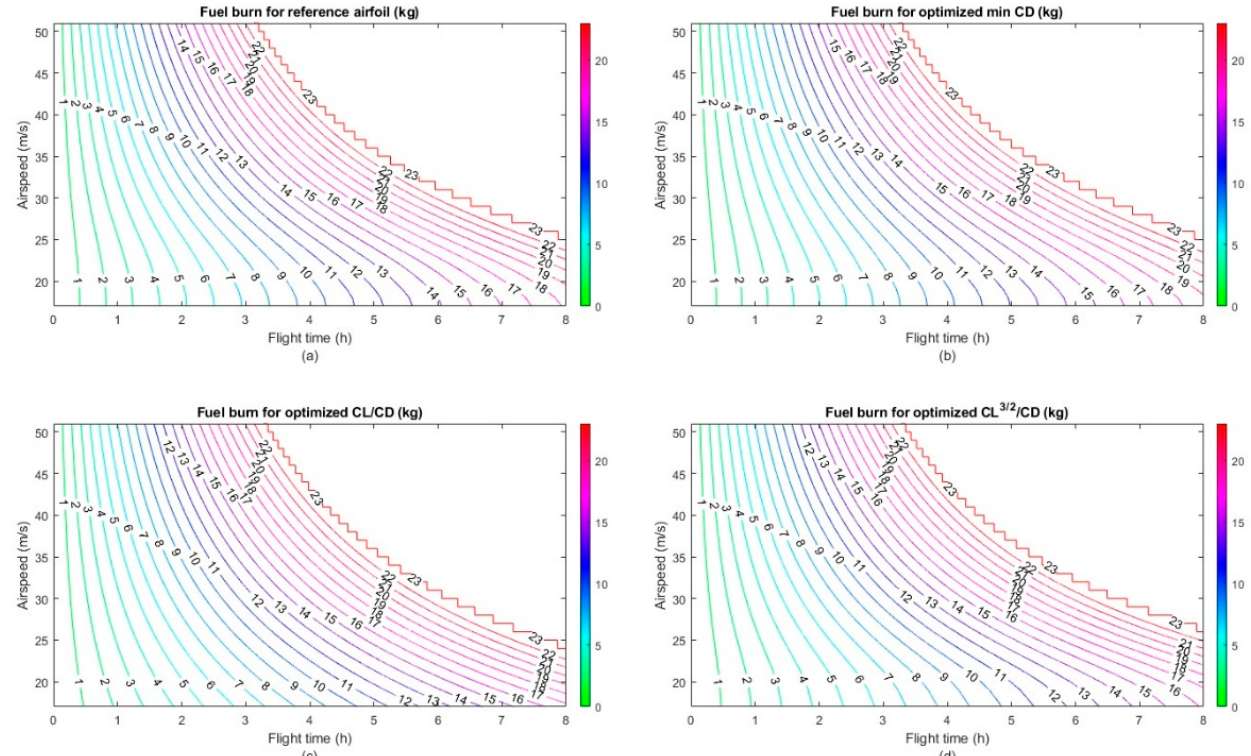
Figure 19. Comparison of fuel burn rate over flight time at different speeds for the reference and optimized configurations for the UAS-S45. ( a ) Fuel burn for reference airfoil, ( b ) Fuel burn for optimized min CD, ( c ) Fuel burn for optimized CL/CD, ( d ) Fuel burn for optimized CL 3/2 /CD.